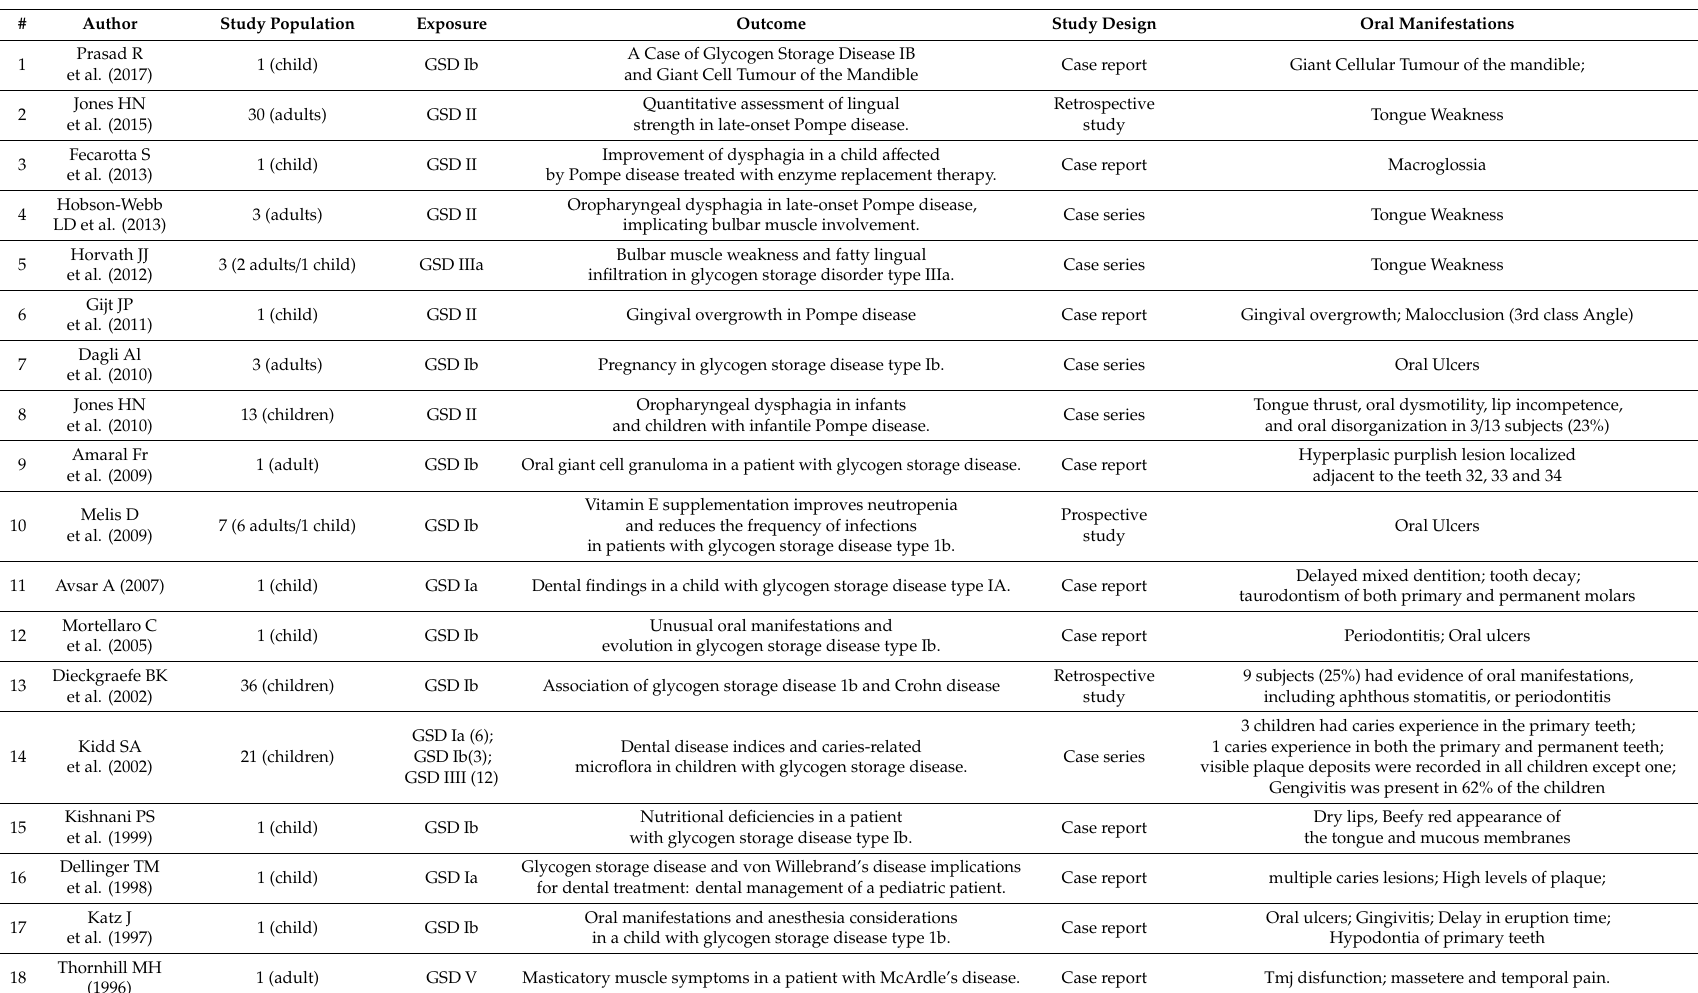
Table 1. First author and year of publication, PICOS information and oral manifestation reported in the 45